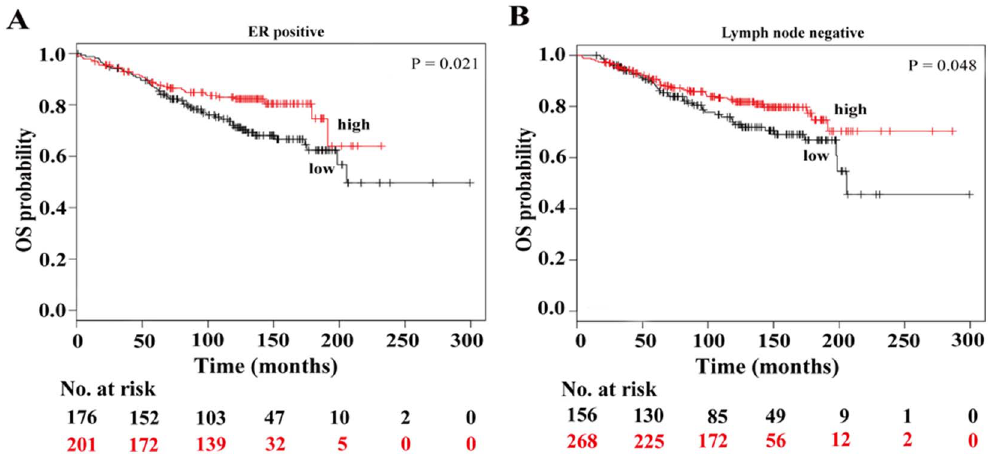
Figure 5. Low expression of C10orf10 is correlated with shorter survival in BC patients from KM plotter with ER positive and lymph node negative. (A) Survival analysis of C10orf10 expression in 377 BC patients with ER positive. Auto select best cutoff was chosen in the analysis; Cutoff value used was 1117; Expression range of the probe was 143–3356. (B) Survival analysis of C10orf10 expression in 424 BC patients with lymph node negative. Auto select best cutoff was chosen in the analysis; Cutoff value used was 923; Expression range of the probe was